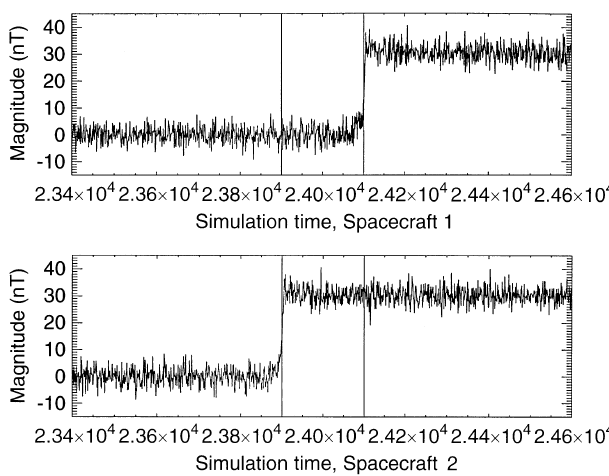
Fig. 3. The magnetic B ? field component as sampled by the spacecraft for the time stationary run. The abscissa shows the simulation time ~ t and the ordinate the corresponding magnetic field. The samples of higher and lower sampling time steps are clipped, since they only represent noise